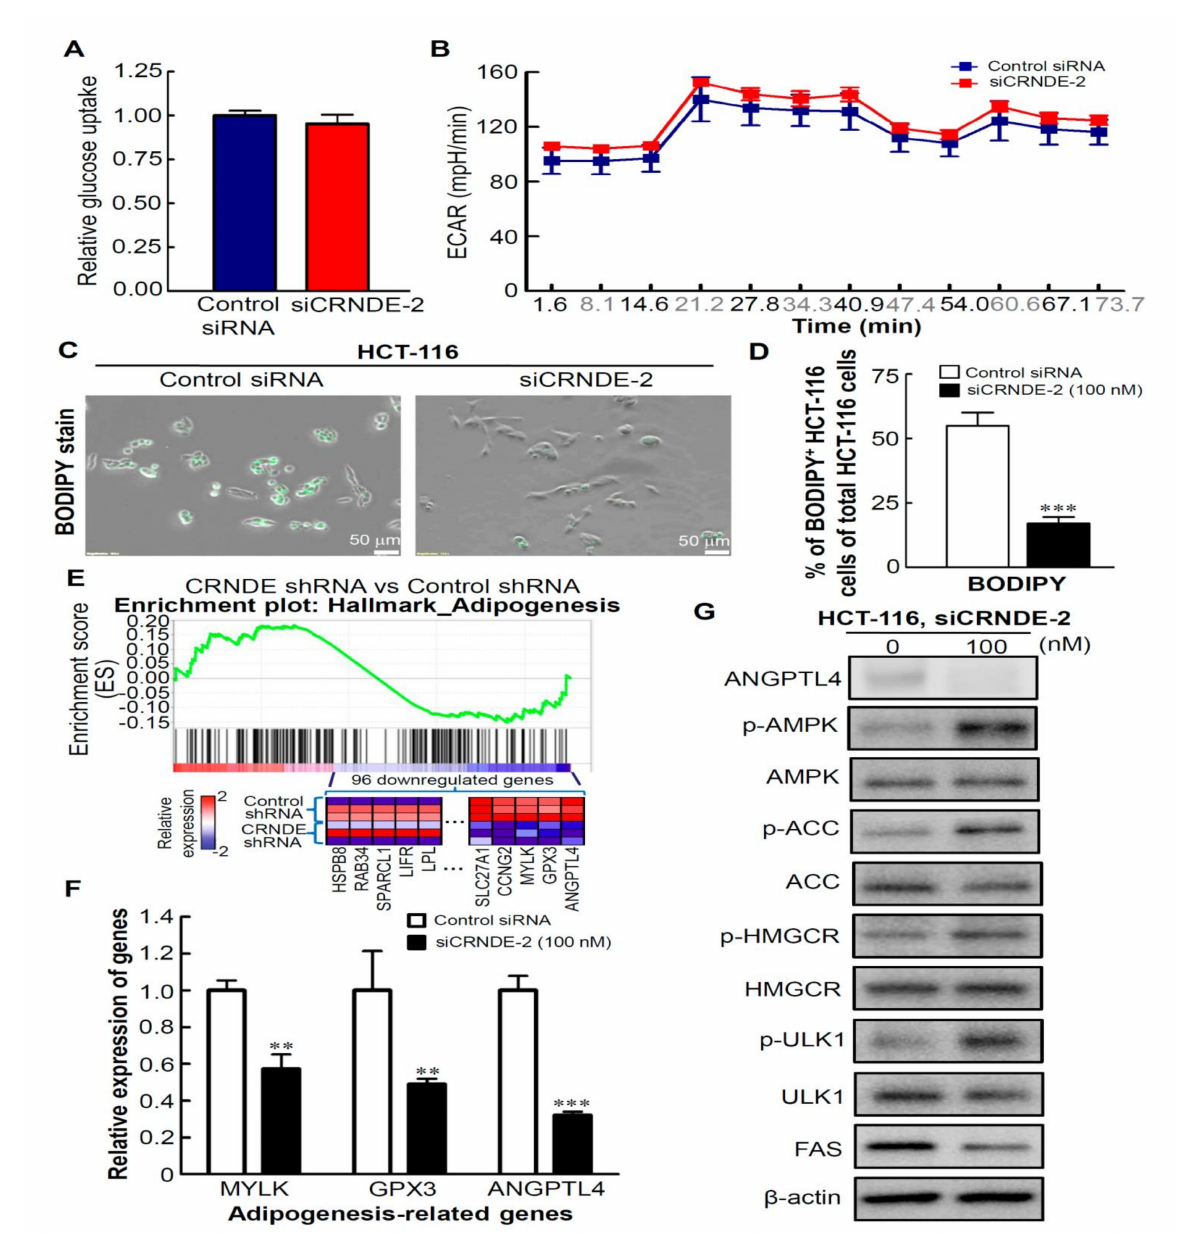
Figure 5. Knockdown of colorectal neoplasia differentially expressed (CRNDE) caused inhibition of lipid metabolism of colorectal cancer (CRC) cells. ( A ) Glucose consumption was determined in CRNDE-knockdown HCT-116 cells. ( B ) Analysis of the extracellular acidification rate (ECAR) of HCT-116 cells with CRNDE-knockdown. ( C ) HCT-116 cells were transfected with CRNDE small interfering (si)RNA for 48 h. Images of BODIPY 505/515 -stained cells were captured with a fluorescence microscope. ( D ) BODIPY 505/515 -stained results were quantified and are represented as multiples of change, considering the control siRNA cell value as 1-fold. Error bars represent the mean ± standard deviation (SD). ( E ) A gene set enrichment analysis (GSEA) showed enrichment of downregulated adipogenesis gene sets in stable CRNDE-knockdown CRC cells. Heat-map image illustrating gene expression levels of the leading edge subset. ( F ) Expressions of representative genes ( MYLK , GPX3 , and ANGPTL4 ) in CRNDE-knockdown HCT-116 cells. ( G ) Western blot analysis of the effects of CRNDE- knockdown on the phosphorylation and expression levels of lipid metabolism-associated targets in HCT-116 cells, including the phosphorylation levels of acetyl-CoA carboxylase (ACC) and hydroxymethylglutaryl-CoA reductase (HMGCR), as well as fatty acid synthase (FAS) protein level. ** p < 0.01, *** p <